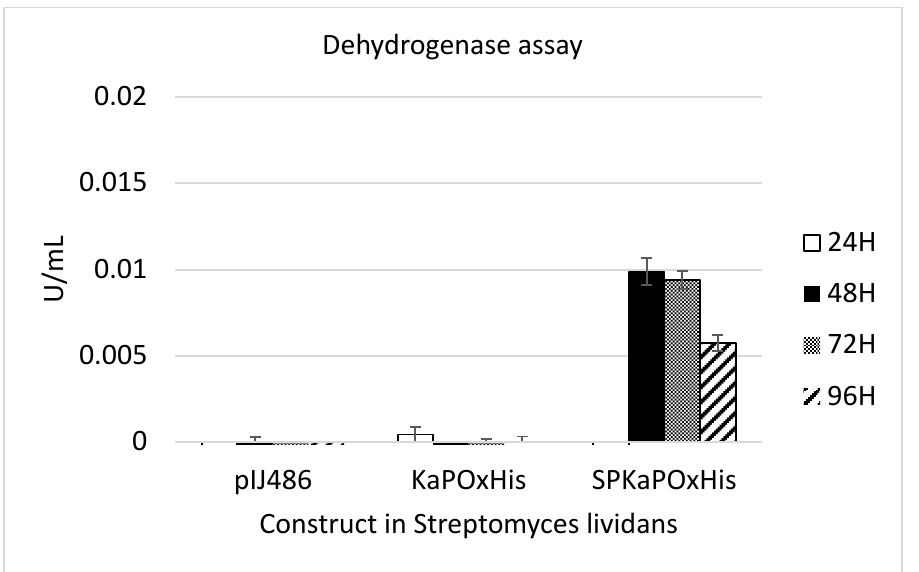
Figure 3. Dehydrogenase activity assay of S. lividans supernatant obtained from cultures harboring the empty vector pIJ486, pIJ486- Ka POxHis, and pIJ486-SP Ka POxHis. Samples were taken from the supernatant at 24, 48, 72 and 96 h (H) as indicated.